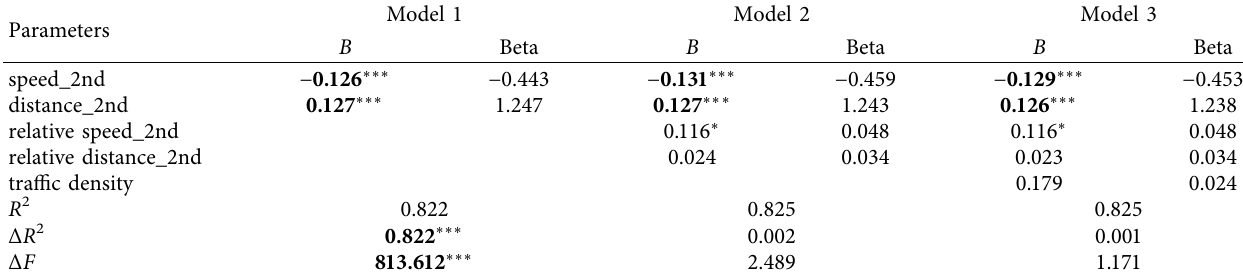
Table 10: Results of the braking duration based on the following state.